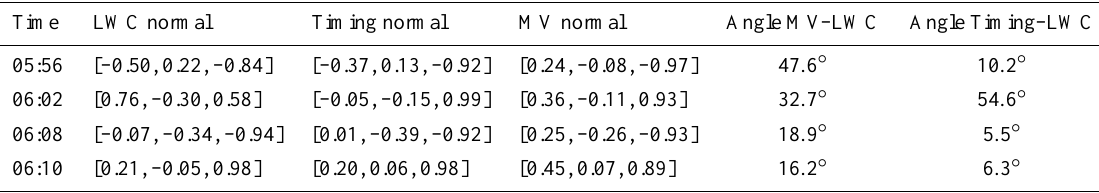
Table 1. Normals from various